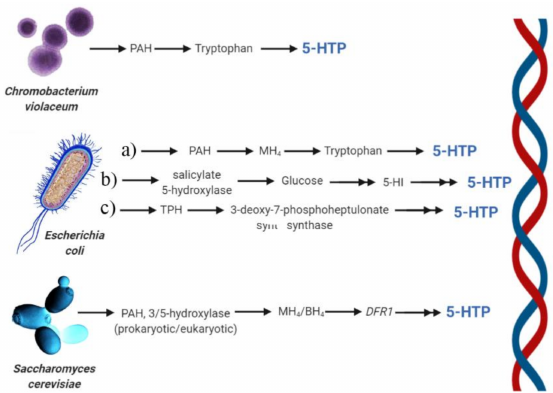
Figure 9. Summary of heterologous production of 5-HTP. Chromobacterium violaceum , with the first use of PAH for tryptophan hydroxylation to 5-HTP. Escherichia coli , with a) utilization of MH 4 instead of BH 4 as the native pterin coenzyme for 5-HTP synthesis, b) the biosynthesis of 5-HTP with the use of a novel salicylate 5-hydroxylase that uses glucose as the substrate for the production of the non-natural substrate anthranilate to 5-hydroxyanthranilate (5-HI), c) substitution of the promoter of aroHfbr gene encoding 3-deoxy-7-phosphoheptulonate synthase to feed the biosynthetic pathway of tryptophan production. The use of yeasts with the heterologous expression of either a prokaryotic PAH or eukaryotic tryptophan 3/5-hydroxylase, together with enhanced synthesis of the two cofactors MH 4 or BH 4 ; the native Saccharomyces cerevisiae gene, DFR1 , which encodes dihydrofolate reductase to catalyze tetrahydrofolate, plays a pivotal role in 5-HTP synthesis by regenerating MH 4 . Created with